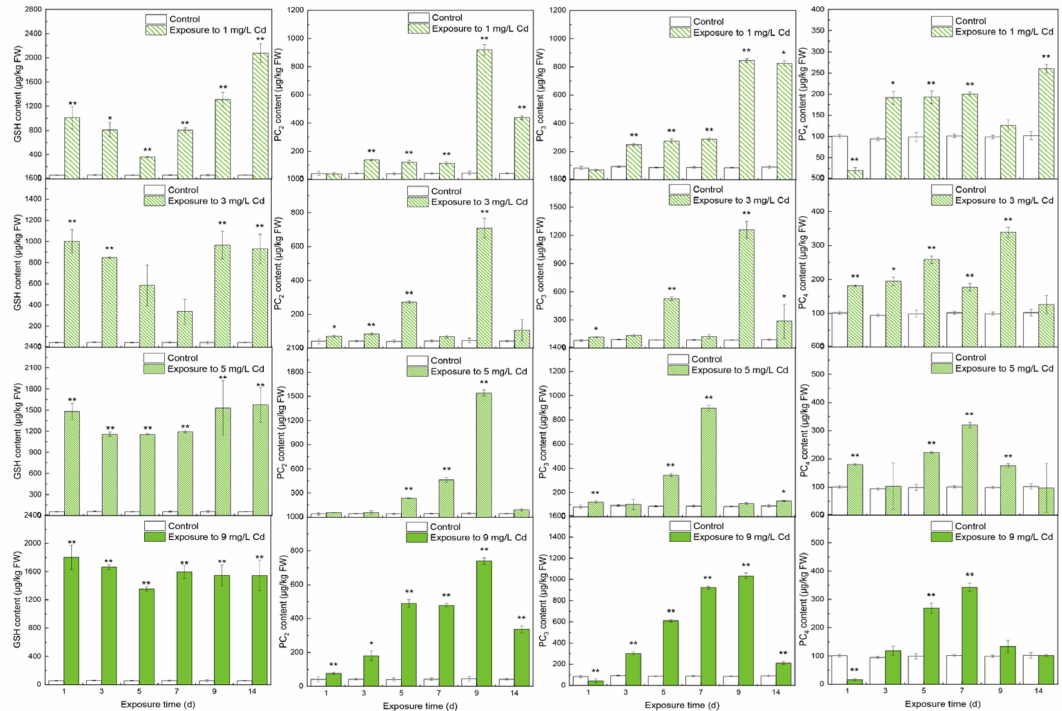
Figure 2. The contents of thiols in leaves under different levels of Cd stress. All values represent the means ± SD of three replicates. Stars indicate significant differences to the control (**: p < 0.01, *: p <